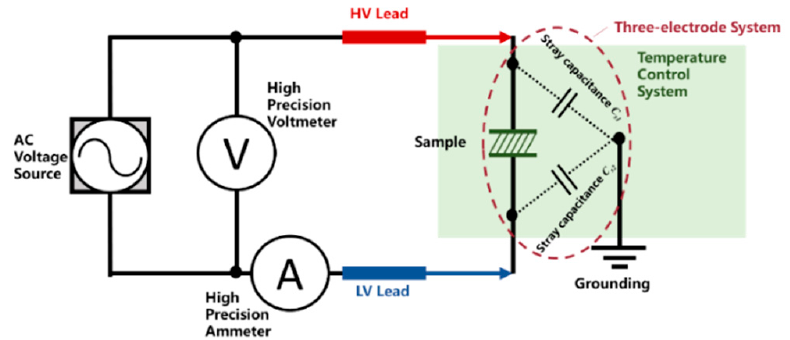
Figure 2. Diagram of the frequency domain spectroscopy (FDS) test circuit. HV: high voltage. LV: low voltage.